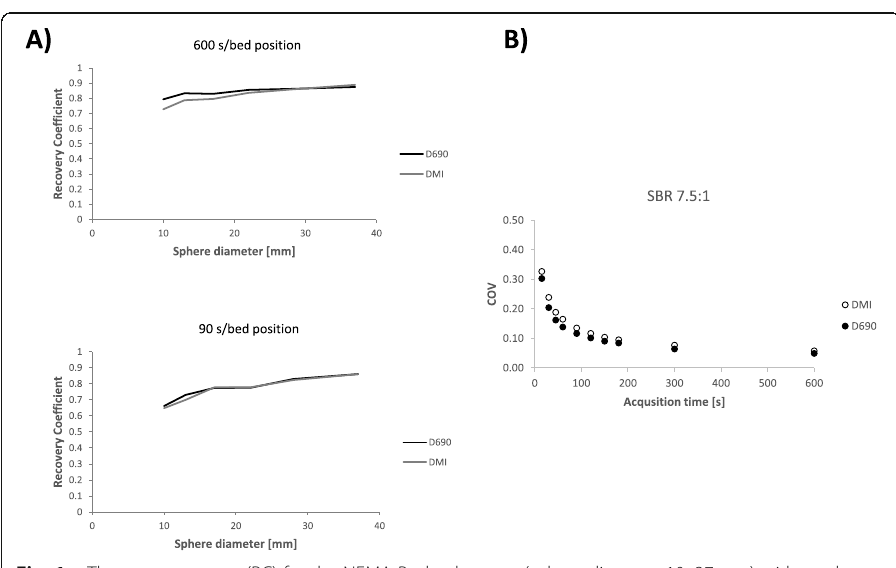
Fig. 1 a The recovery curve (RC) for the NEMA Body phantom (sphere diameter 10 – 37 mm) with a